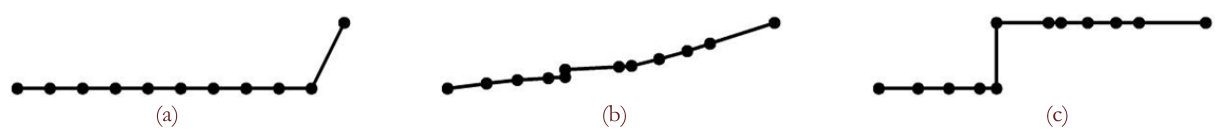
Figure 5: Weackened 1d bar: FE discretization.